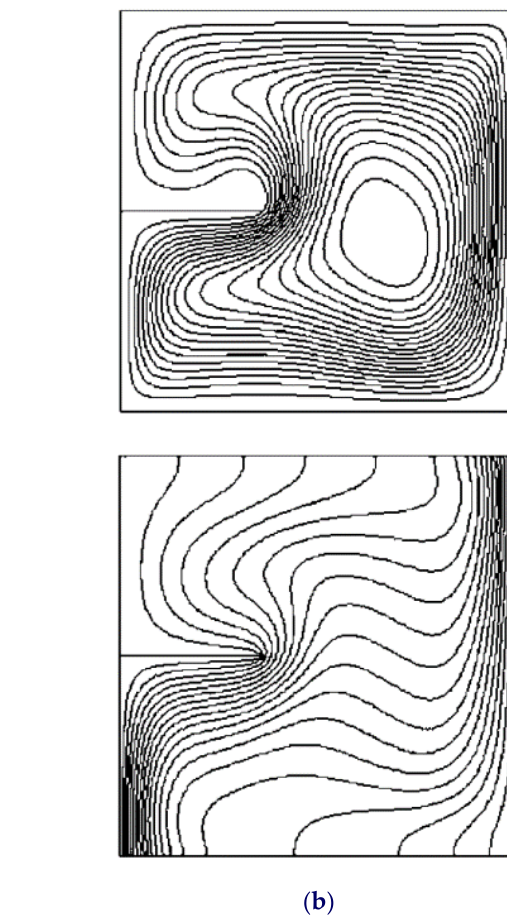
Figure 4. Comparison of the ( a ) Isothermal lines with previous results ( θ ) and stream function ( Ψ ) at 𝑃𝑟 = 0.707, 𝑅𝑎 = 10 5 , 𝑆 = 0.5, and 𝐿𝑓 = 0.35 with ( b ) Ben-Nakhi and Chamkha [55].